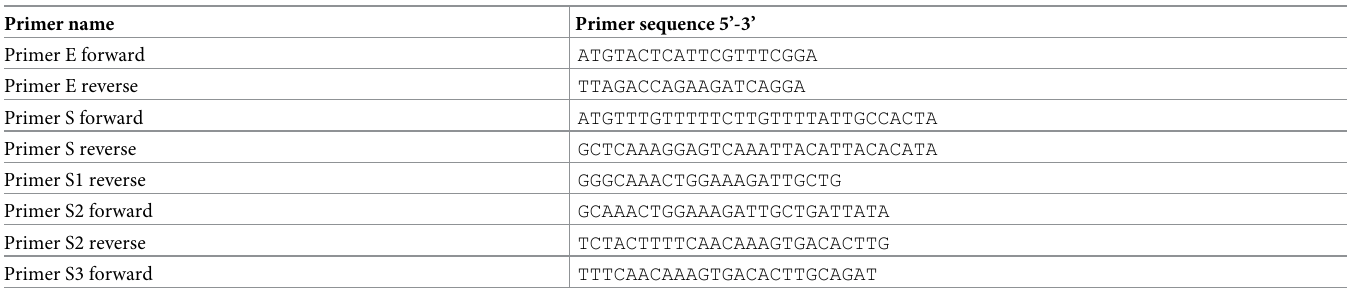
Table 1. Sequences of primers adopted for Sanger sequencing of E and S genes.